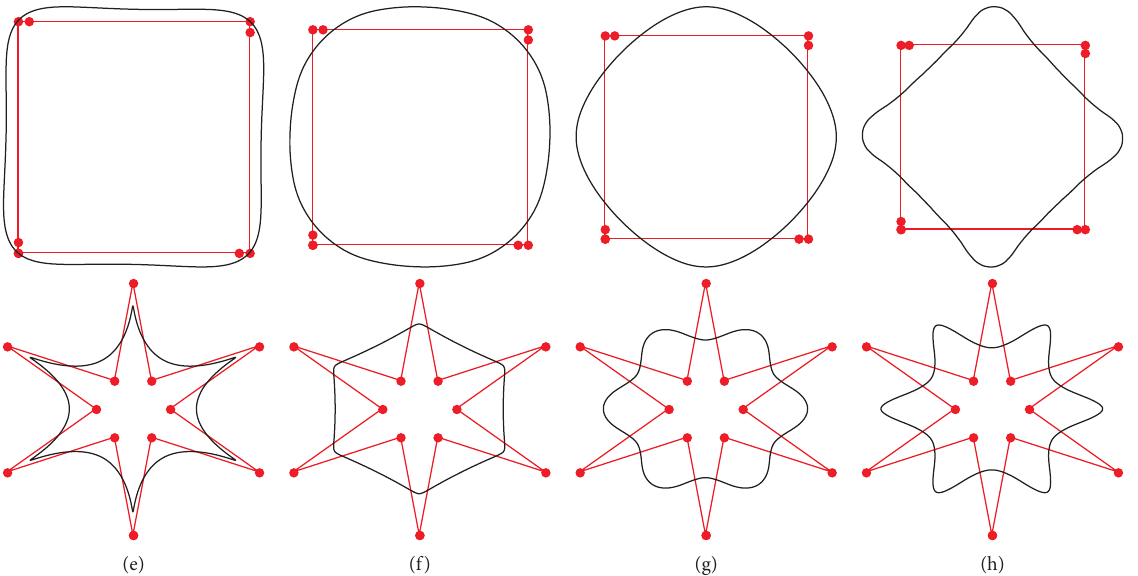
S a 3 in (a–d) and by subdivision scheme a 5 in (e–h), respectively: